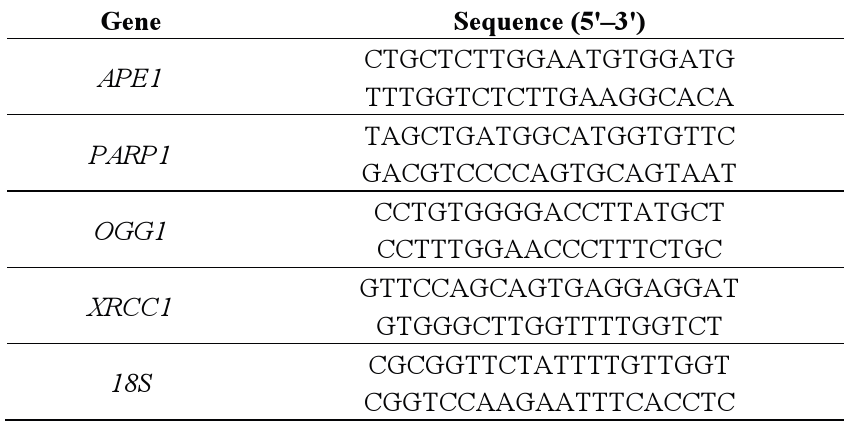
Table 4. Primers used for PCR-RFLP and real-time